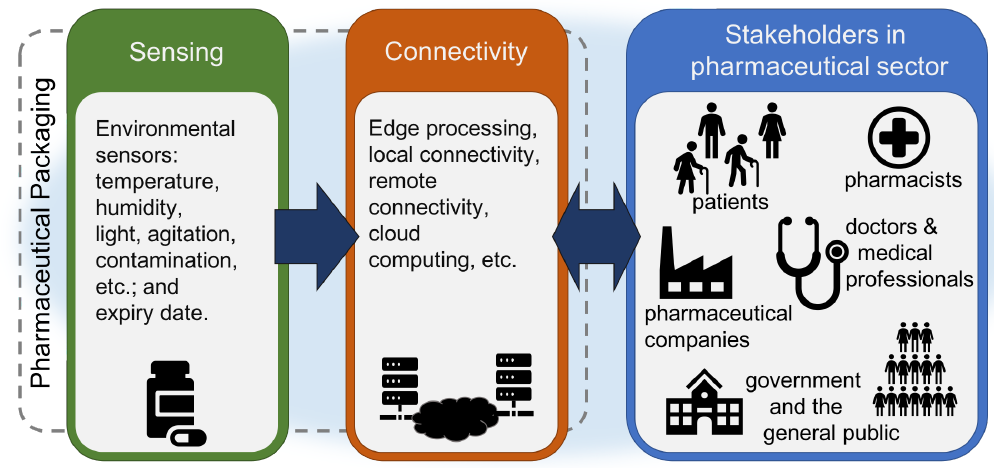
Figure 1. Typical IoPT architecture for medicine reuse derived from the ReMINDS ecosystem